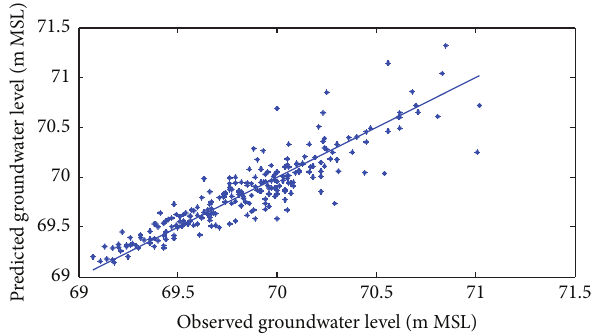
Figure 17: Scatter plots of observed and predicted groundwater levels using an ANFIS model (Pp